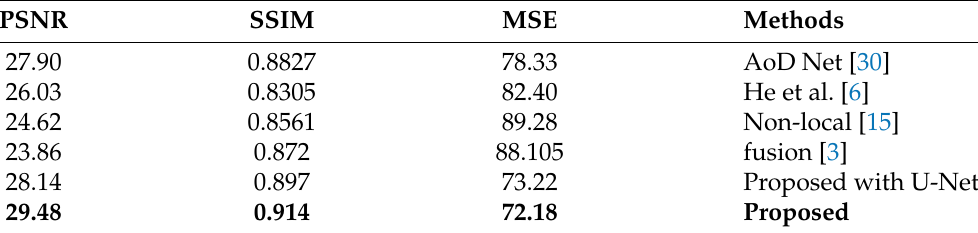
Table 3. Quantitative comparison for the DIV2K dataset